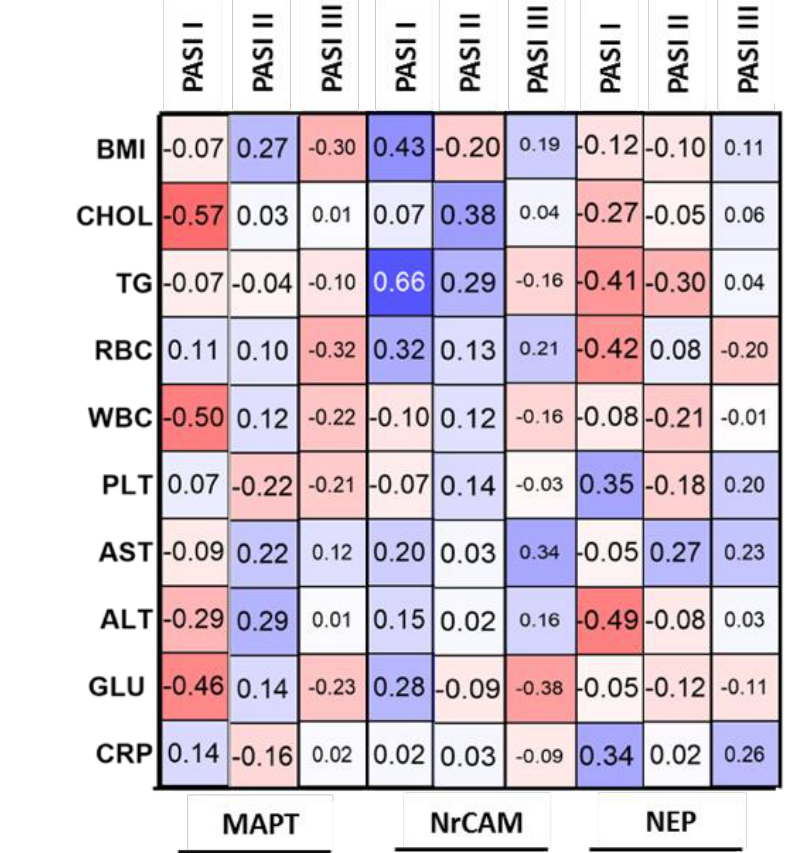
** — means the existence of statistically significant difference between patients single group com- pared to controls with p < 0.01.